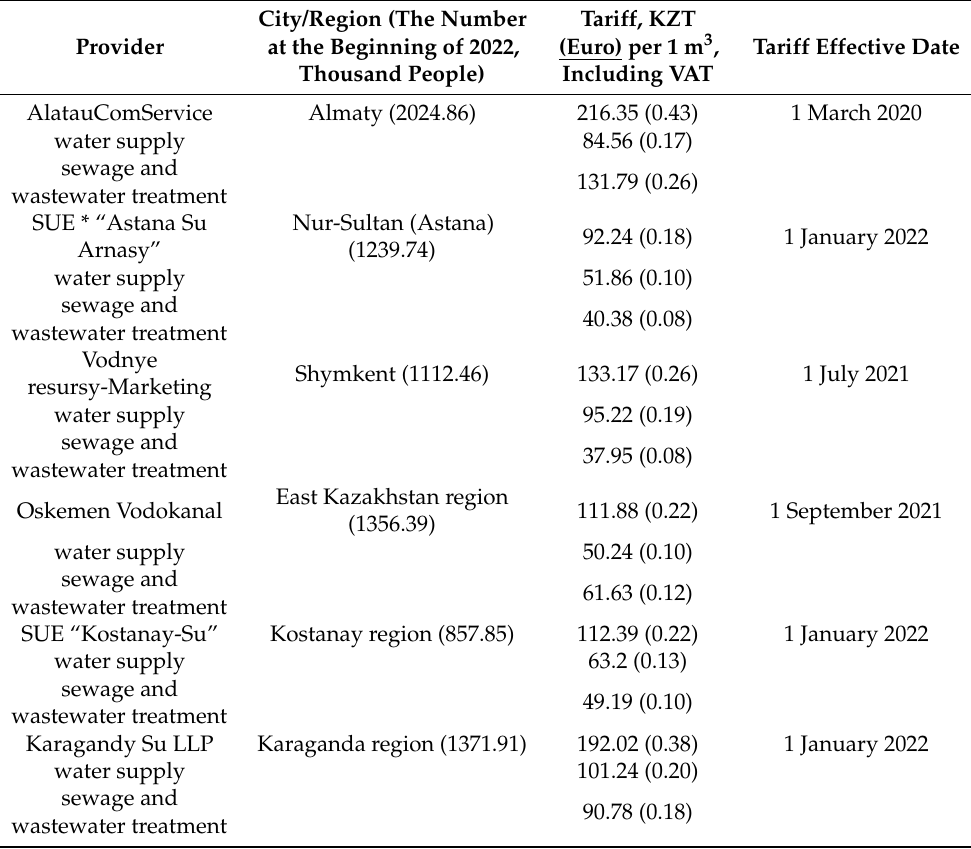
Table 4. Tariffs for water supply and sewage